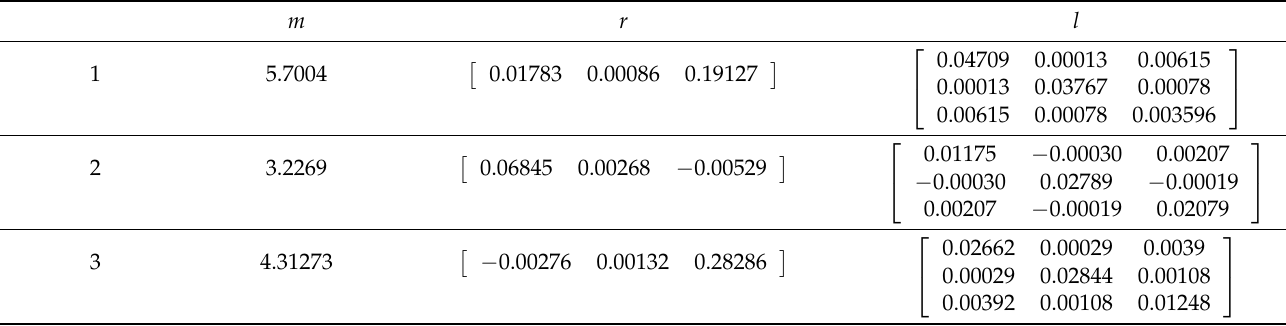
Table 1. Parameters of each rod of Baxter